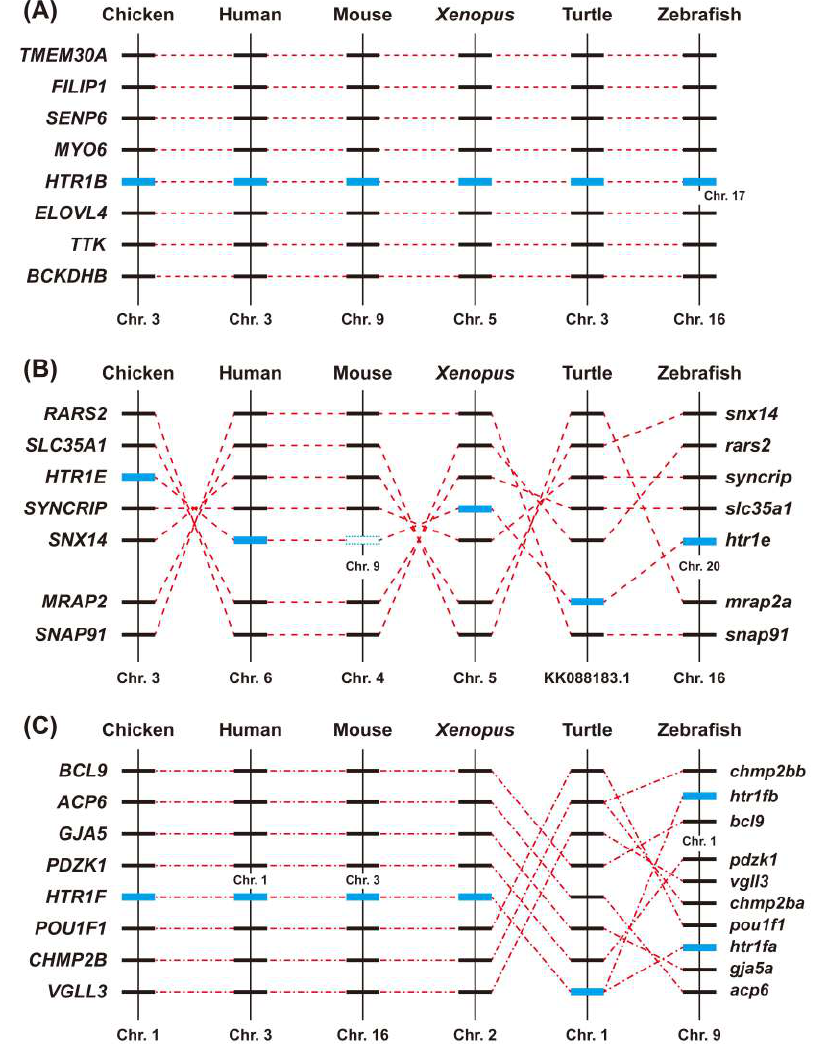
Figure 3. Synteny analysis of HTR1B , HTR1E , and HTR1F in chickens and other vertebrates. HTR1B ( A ), HTR1E ( B ), and HTR1F ( C ) are located in three syntenic regions conserved in vertebrate species, including chickens, humans, mice, X. tropicalis , painted turtles, and zebrafish. Blue boxes denote the genes of interest, while dotted lines indicate the syntenic genes identified in these species.